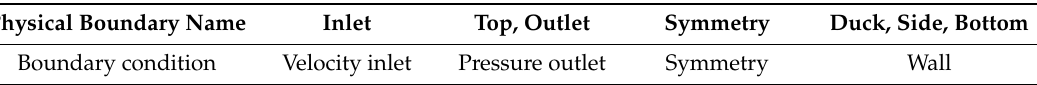
Table 1. Boundary conditions for all physical